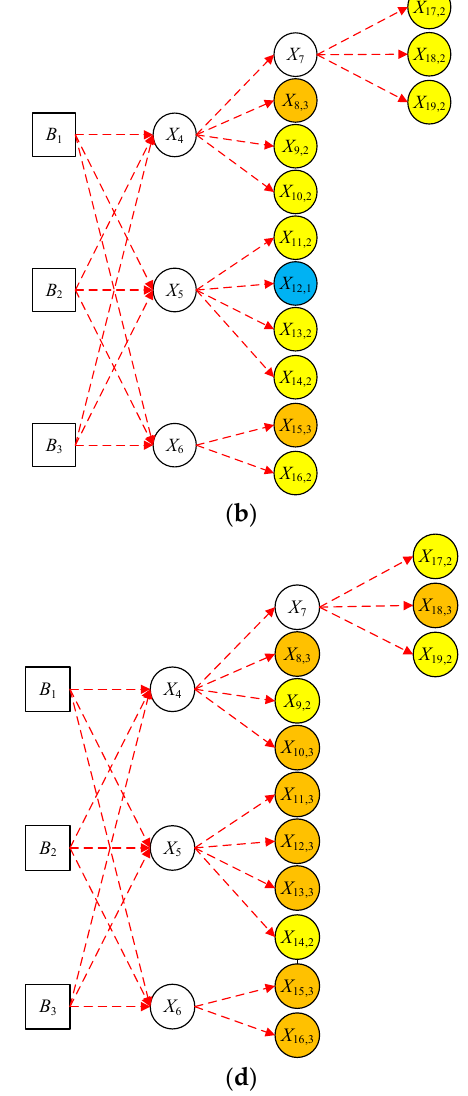
Figure 9. Evaluation models of shale-gas sweet spots with E in ( a ) Changning with E 1 , ( b ) Weiyuan with E 2 , ( c ) Fushun- Yongchuan with E 3 , and ( d ) Jiaoshiba with E 4 . Table 5. Shale-gas data of four areas in the Sichuan basin. After the state of the variable was determined, based on the conditional events in Table 4, the state of the unknown variable in Figure 9 was determined and then simplified according to DUCG simplification rules. During simplification, the action events that met the conditions were indicated by a solid red line, as shown in Figure